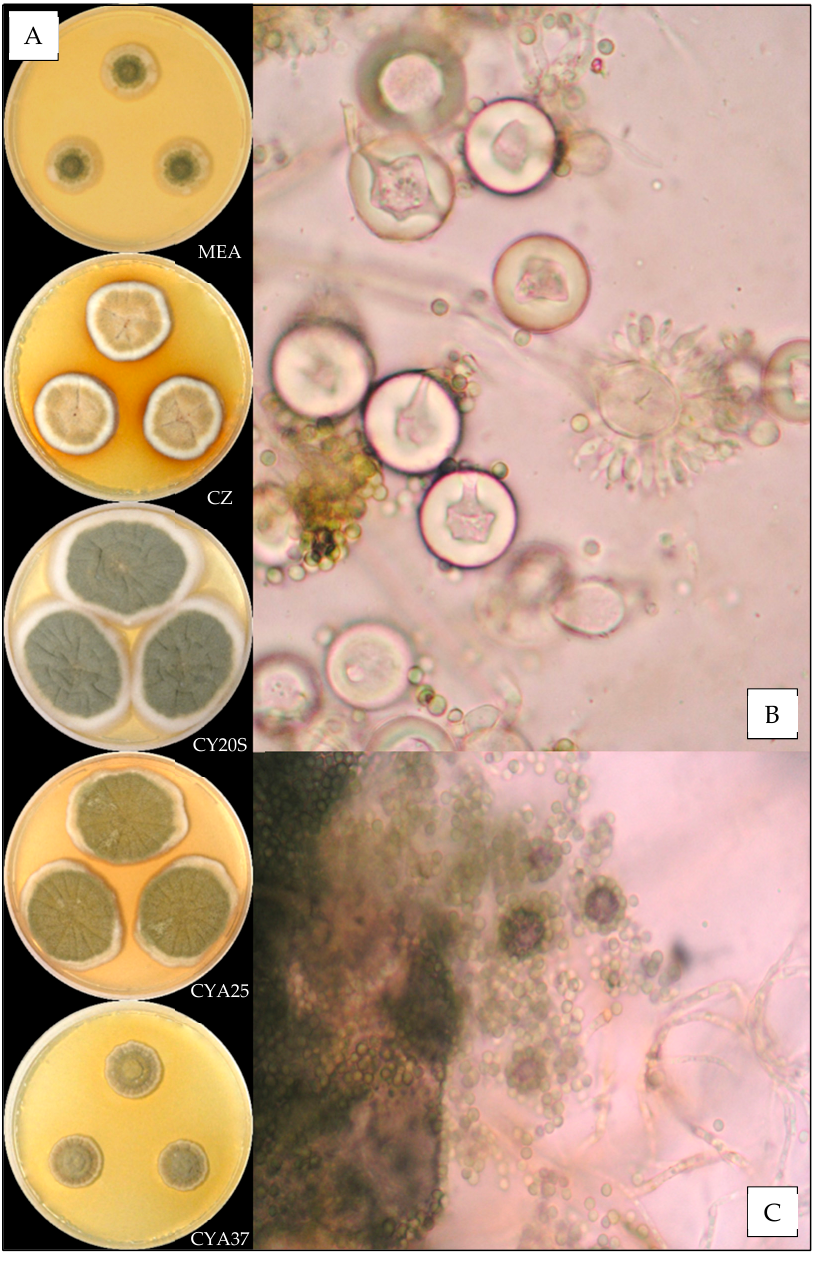
Figure 6. Aspergillus protuberus : ( A ) from top to bottom, colonies on MEA, CZ, CY20S, CYA25 and CYA37, 14 days. ( B ) Conidial head and Hülle cells and ( C ) conidia (×1000).